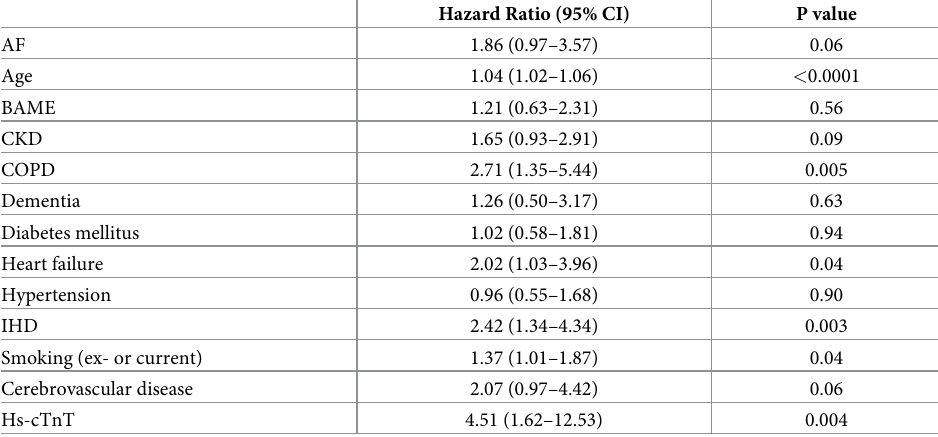
Table 3. Univariate cox regression analysis of predictors of mortality in COVID-19.